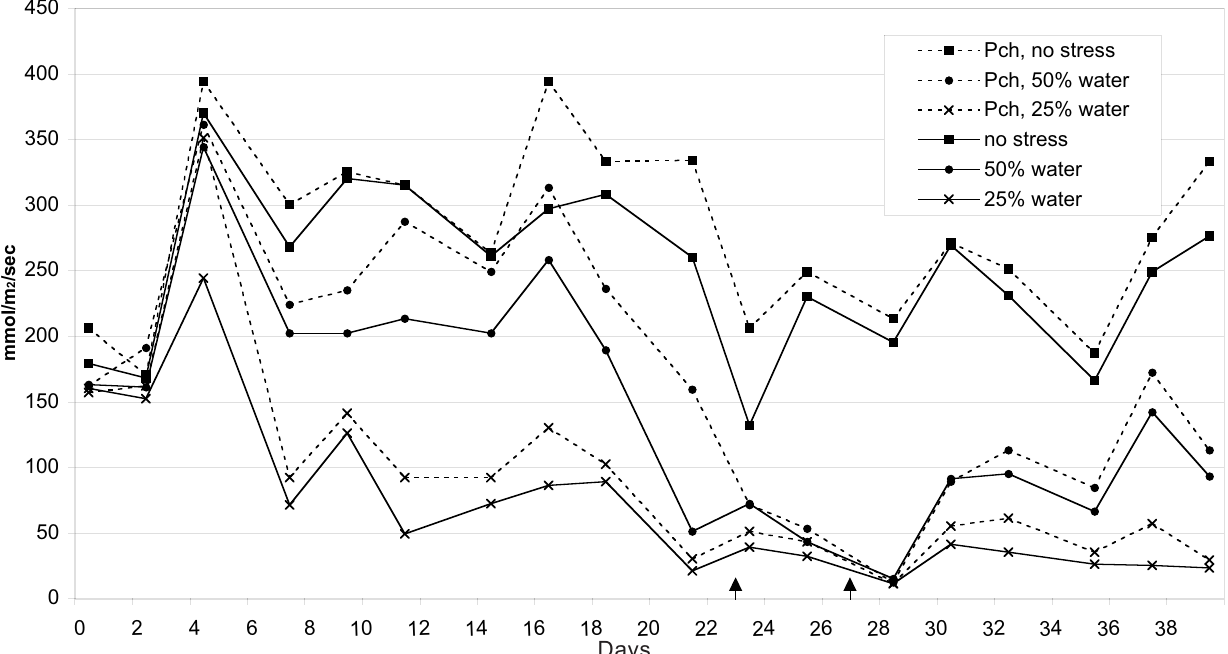
Fig. 1. Effect of water stress on stomatal conductance of infected and uninfected Cabernet Sauvignon, November 2005. The arrows indicate the period when water was completely withheld from the stress treatments.